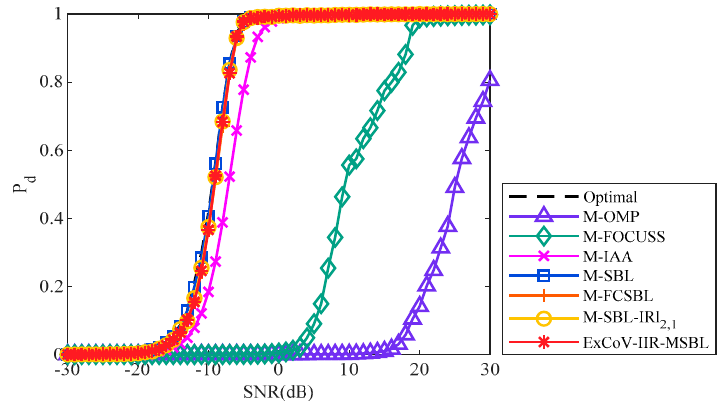
Figure 7. Probability of detection versus signal to noise ratio.